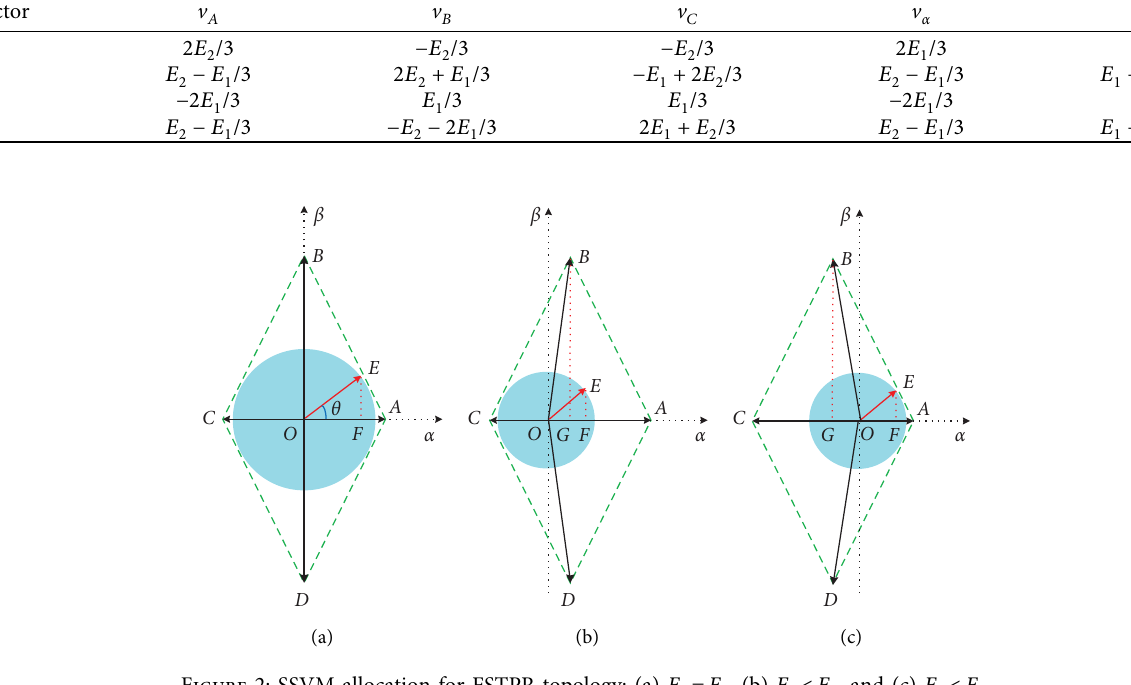
� E 1 2 , (b) E 1 < E 2 , and (c) E 2 < E 1 .